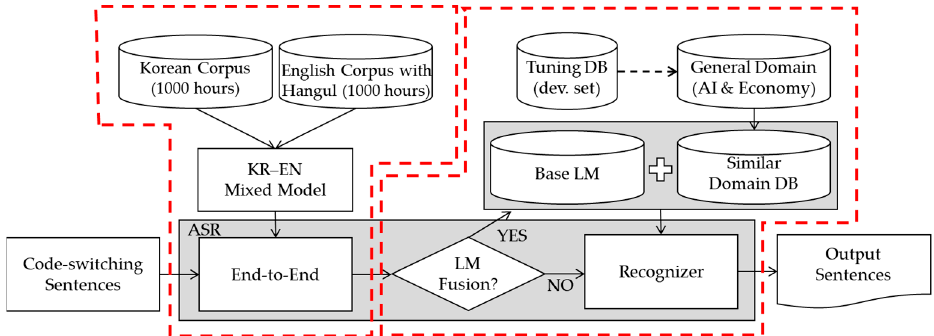
Figure 4. Overall structure of the Korean ASR for code-switching (CS); creating the Korean-Konglish mixed model (left dotted line); applying domain adaptation (right dotted line). ASR, automatic speech recognition; dev. set, development set; EN, English; KR, Korean; LM, language model.